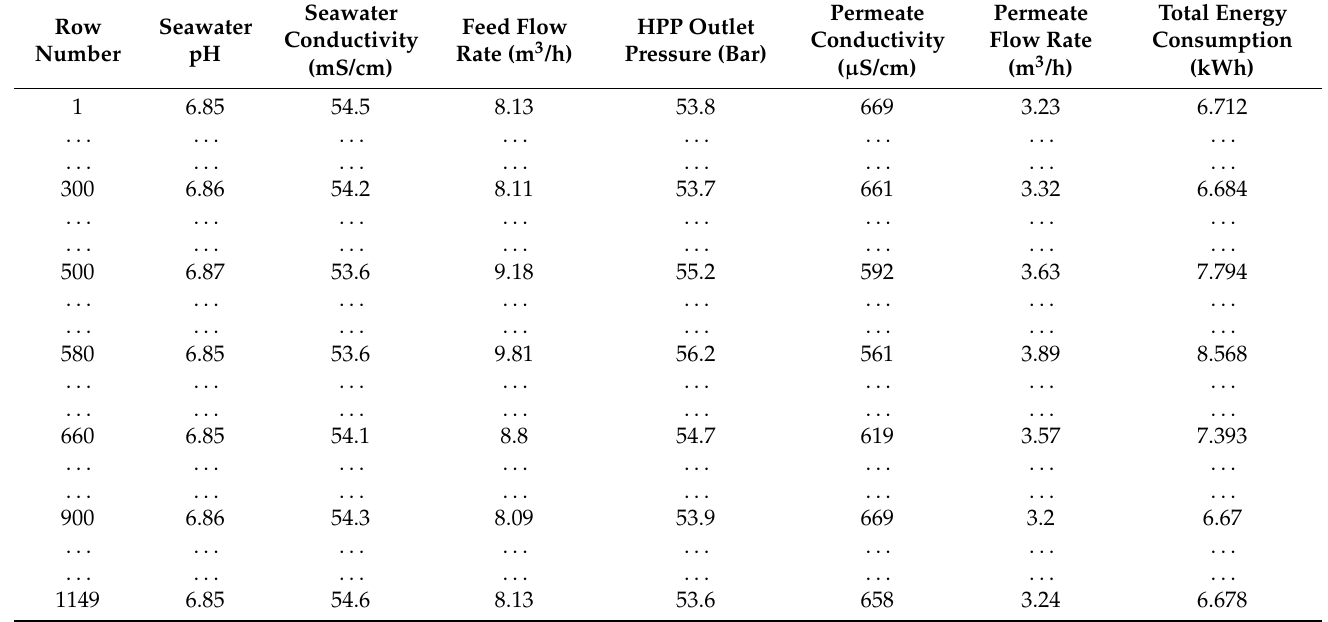
Table 2. Sample of the data recorded during a 24 h